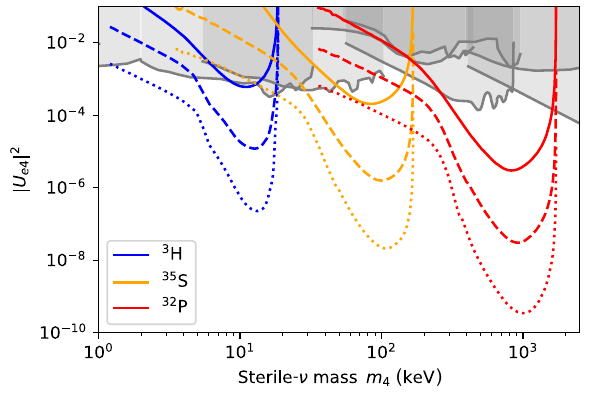
FIG. 5. The estimated sensitivity for a variety of nanosphere sizes, exposures, and β -decay isotopes spanning a sensitivity range from approximately 1 to 1000 keV. The background-free sensitivity for exposures of 1 nanosphere × 1 month (solid), 10 nanospheres × 1 year (dashed), and 1000 nanospheres × 1 year (dotted) are shown. The nanosphere sizes and loading fractions assumed for each isotope are described in the text. The most sen- sitive existing laboratory limits are also shown (gray)